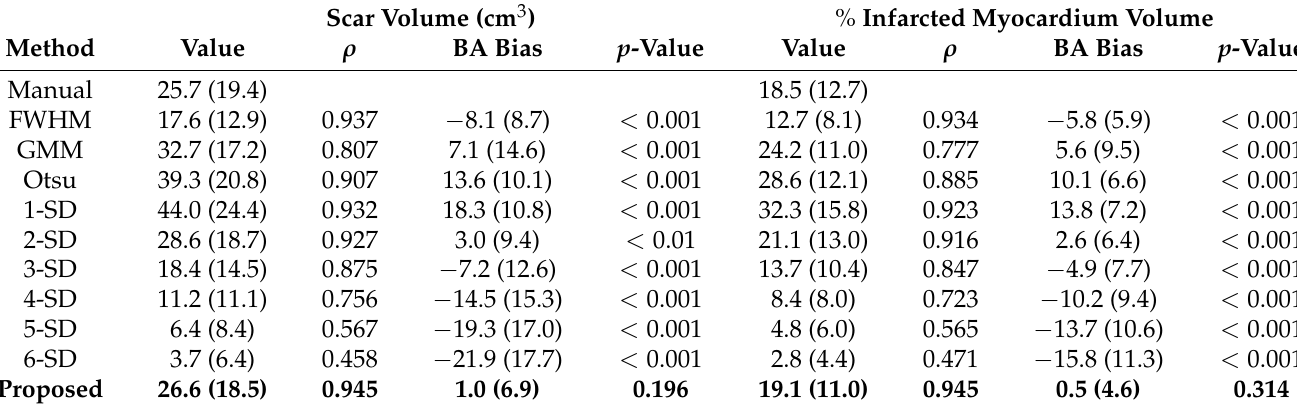
Table 5. Agreement between methods and the manual delineations by means of clinical markers.